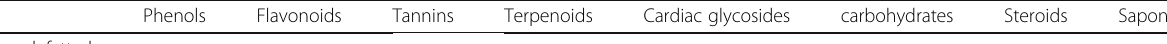
Table 1 Qualitative phytochemical tests of A. karroo extracts Phenols Flavonoids Tannins